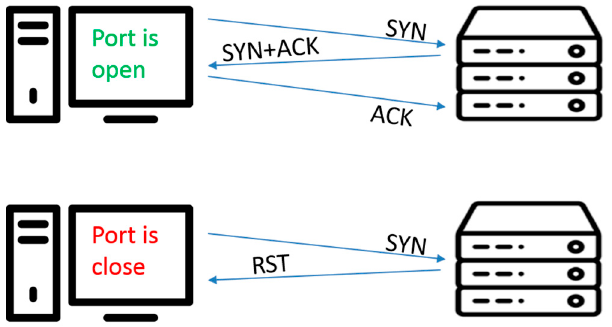
Figure 2. TCP three-way handshake port scanning.